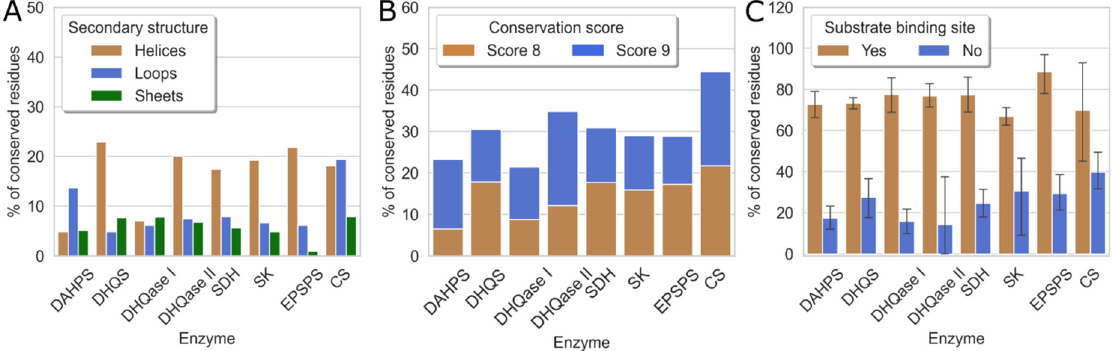
Figure 4. The proportion of evolutionarily conserved residues for individual enzymes. ( A ) Distribution of grade 8 and 9 residues among α -helices, β -sheets, and loops; ( B ) distribution of residues with conservation scores 8 and 9; and ( C ) binding sites identified by SiteMap.